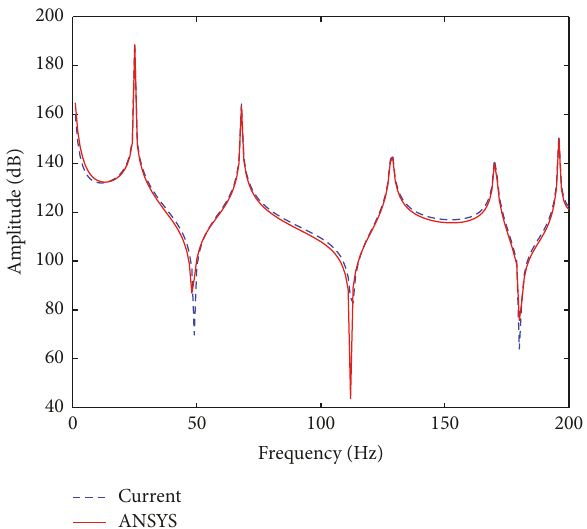
Figure 12: The response of the cylindrical shell subjected to a normal point force.